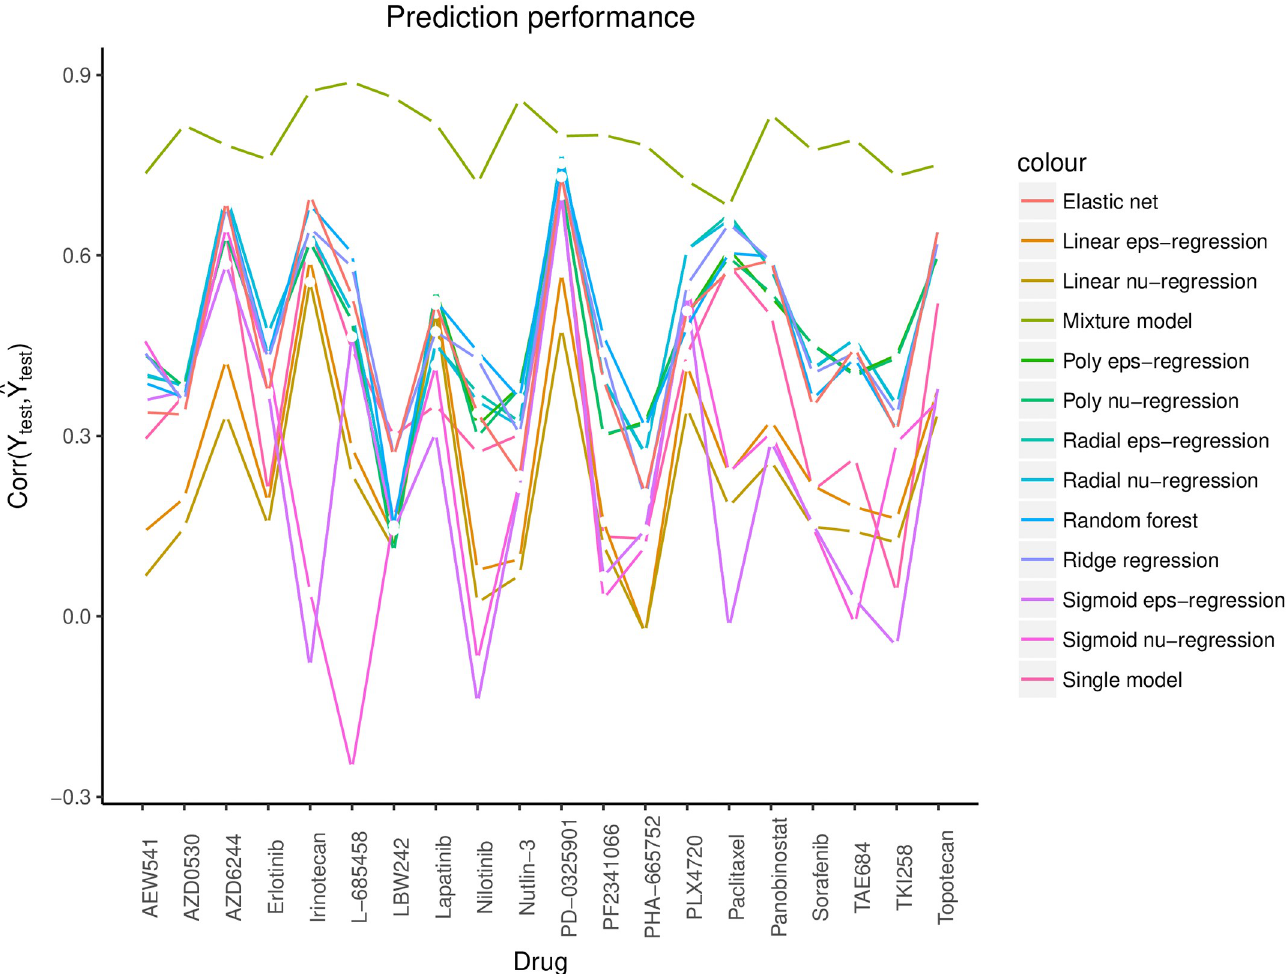
Fig 4. Prediction performance comparison. Comparison of the prediction performance (measured by corr( Y test , ^ Y support vector regression, random forest, ridge regression, elastic net, and SIS-MCP regression (i.e., single model regression).